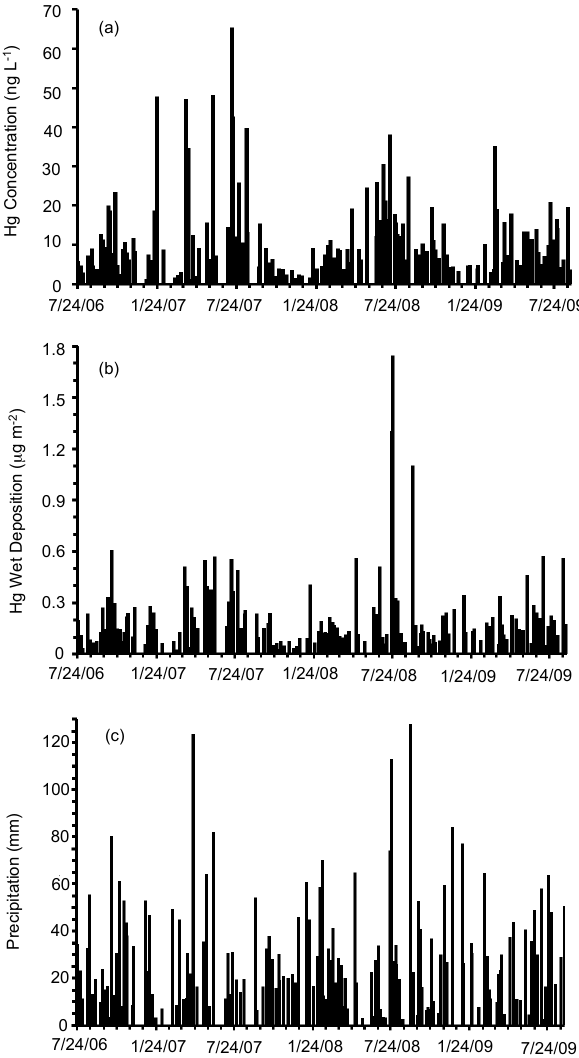
Fig. 2. Time series of wet deposition samples from Thompson Farm; (a) Hg concentration, (b) Hg wet deposition, (c) precipita- tion amount.